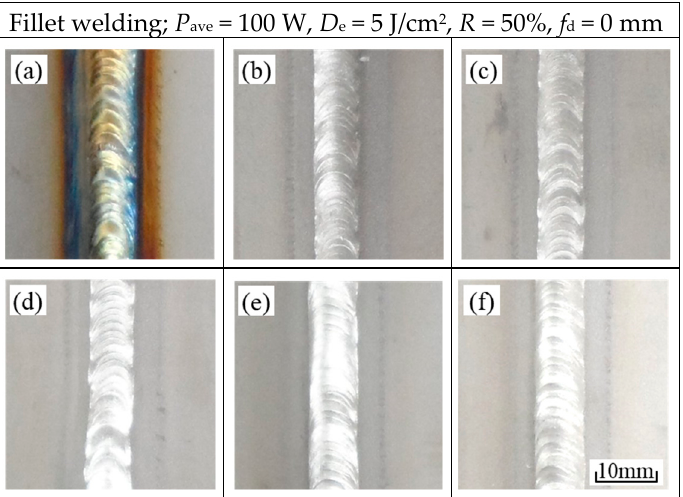
Figure 9. Photos of the laser cleaned surface according to laser head tilt angle of the fillet weld; ( a ) Un-cleaned, ( b ) 35°, ( c ) 40°, ( d ) 45°, ( e ) 50°, ( f ) 55°.